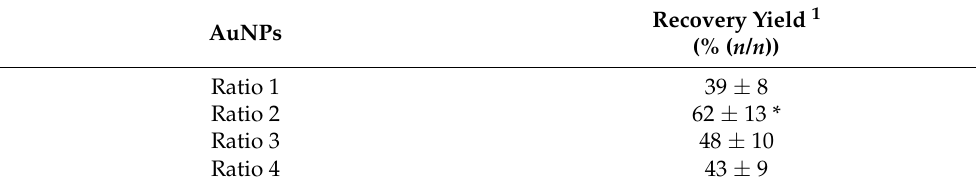
Table 3. AuNP recovery yield in terms of the Au element concentration.